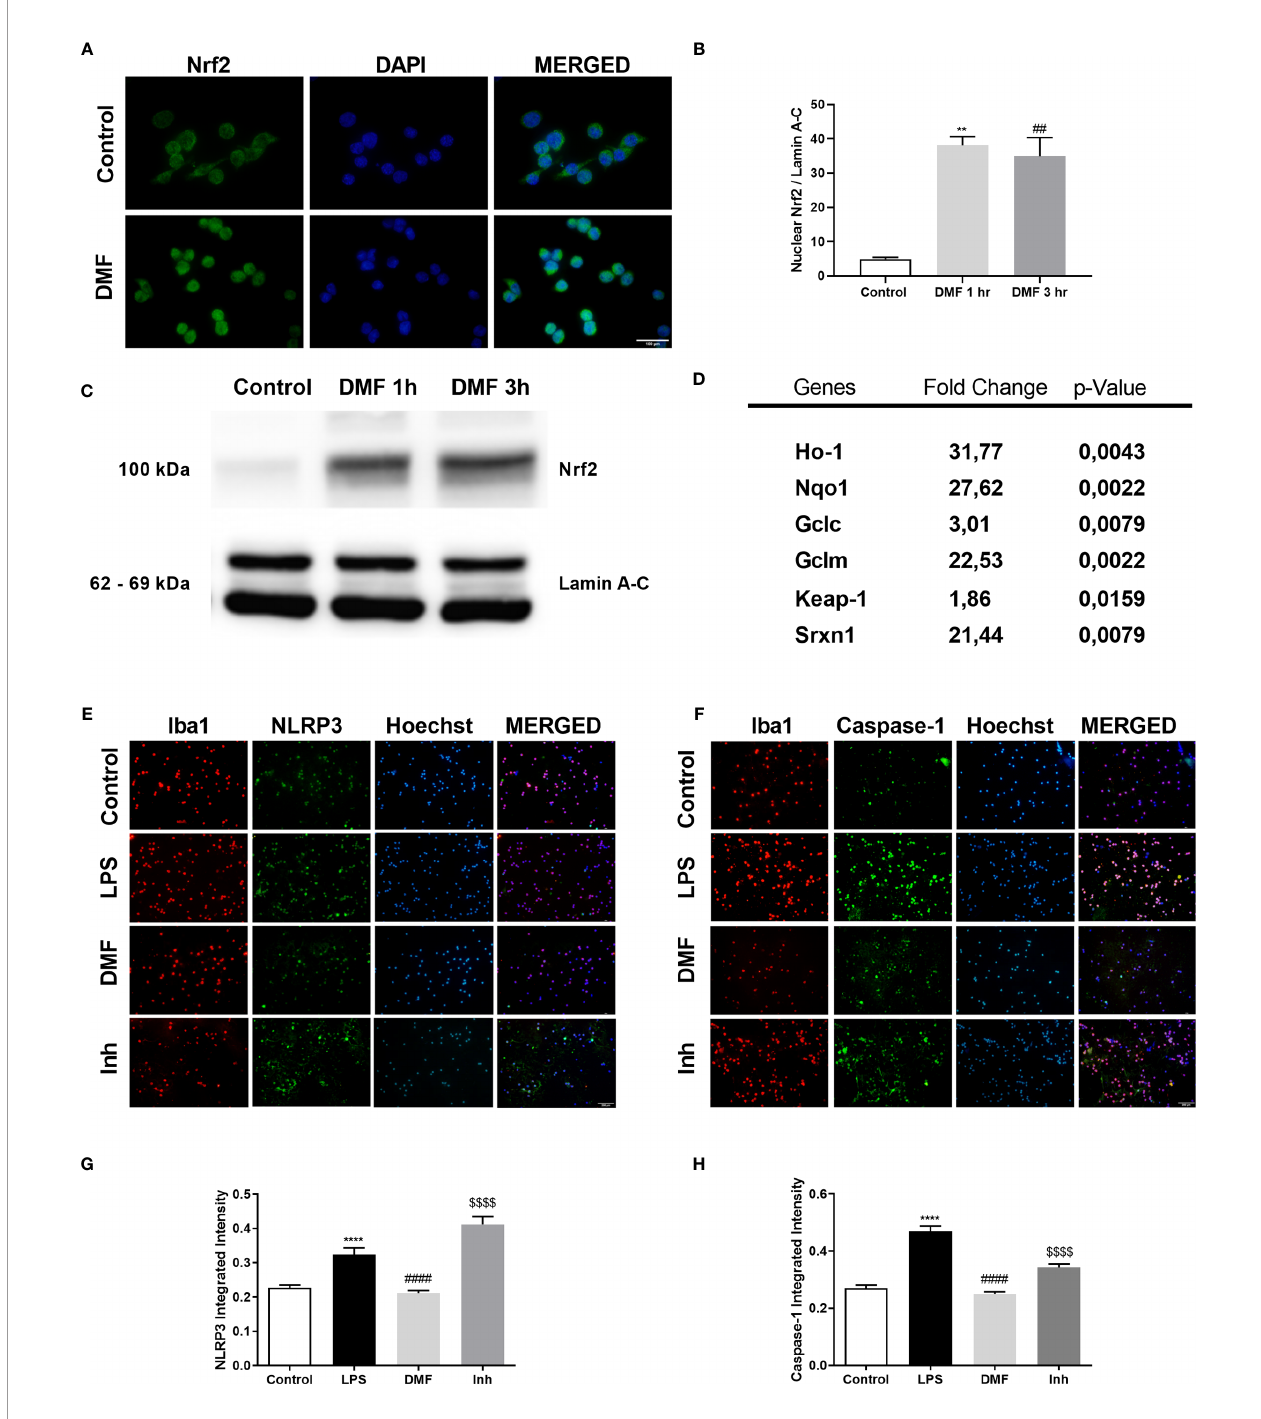
FIGURE 6 | DMF induced Nrf2 activity, and inhibition of Nrf2 activity ameliorated the protective effects of DMF against microglial NLRP3 in fl ammasome activation. N9 microglia were treated with DMF (10 µM) for 1h or 3h. DMF induced the translocation of transcription factor Nrf2 into the nucleus and induced expression of Nrf2 target genes. (A, C, D) Translocation of Nrf2 was demonstrated with IF staining (Green staining – Nrf2, Blue staining – Hoechst) and Western blot. (B) mRNA levels of Nrf2 target genes were measured with qRT-PCR. (E – H) DMF reduced NLRP3 and Caspase-1 expression in microglia isolated from LPS-challenged mice (Red staining – Iba1, Green staining – Nlrp3/Caspase-1, Blue staining – Hoechst). Data are presented as mean ± S.E.M, n = 5. **p < 0.01, ****p < 0.0001 compared to control and ## p < 0.01, #### p < 0,0001 compared to LPS-challenged cells; $$$$ p < 0,0001 compared to DMF pretreated